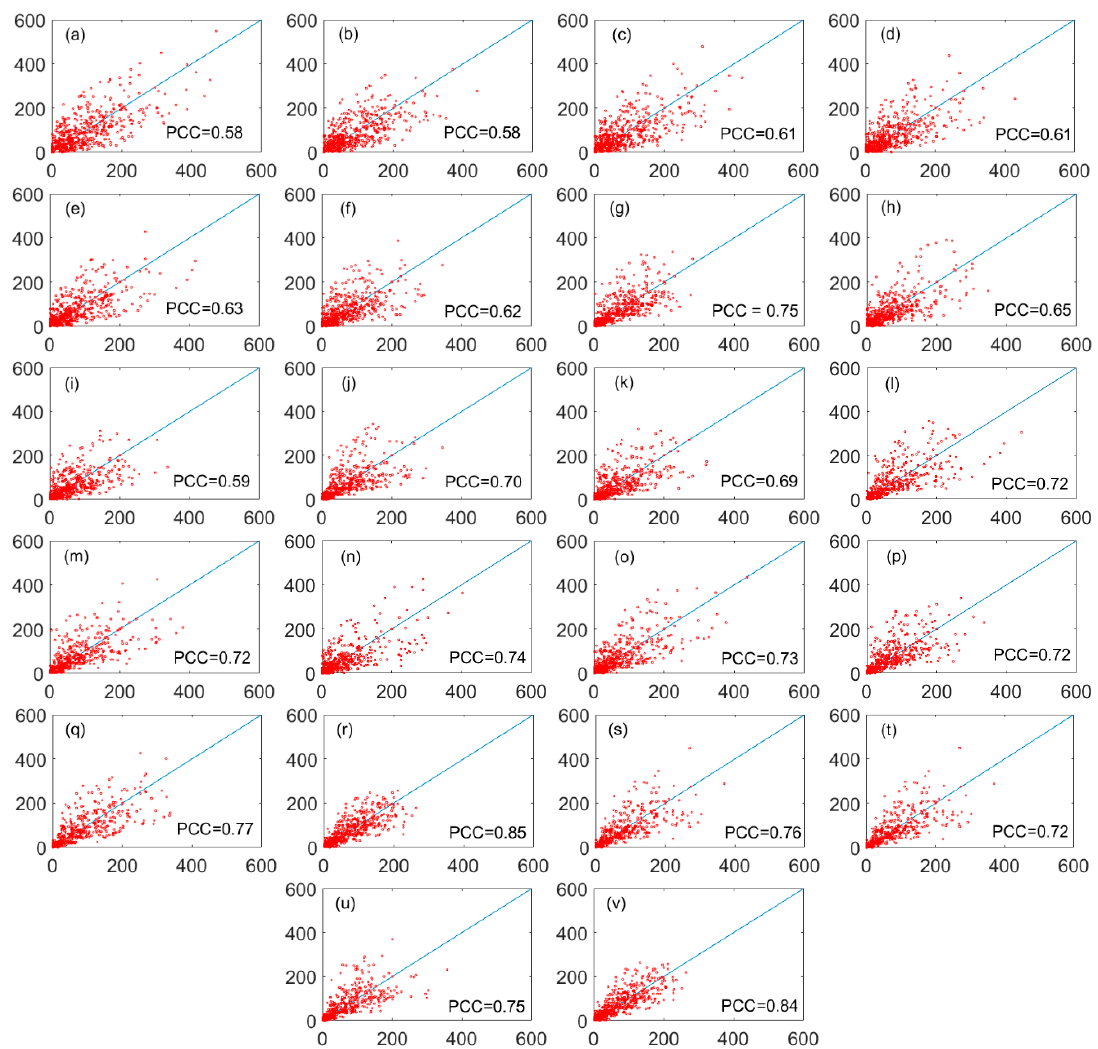
Figure 5. Scatter plots between the SVR_QM results and the monthly observations for each station ( a – u ) and the region mean ( v ) in the period of 1961–2005. Horizontal axes show observed precipitation, and vertical axes show the SVR_QM results.